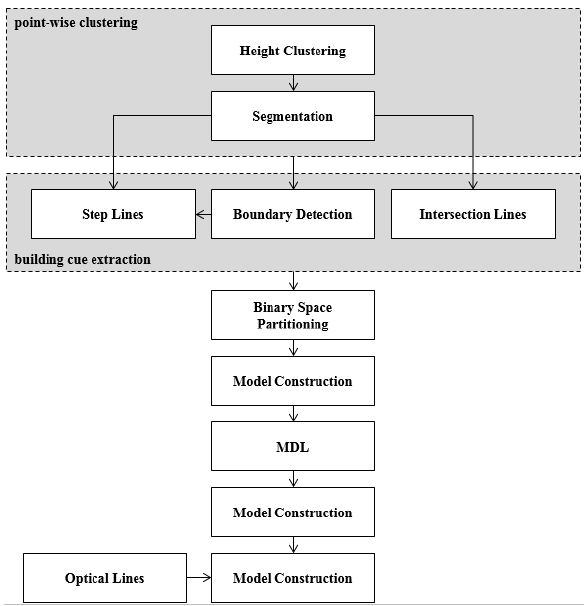
Figure 2. Overview of the reconstruction process based on BSP presented by Sohn et al. (2008, 2012,